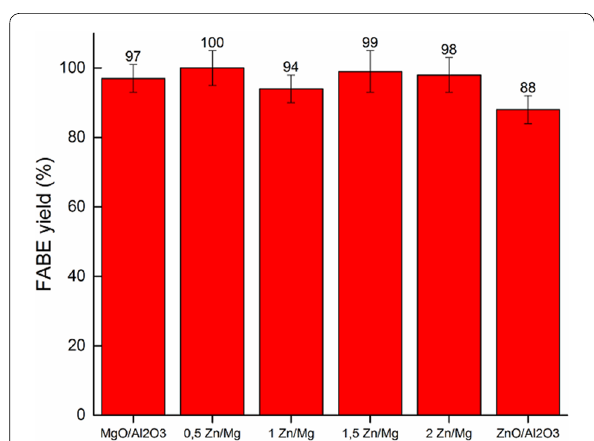
Fig. 9 FABE yield (%) obtained for the prepared catalyst, in the transesterification of castor oil with